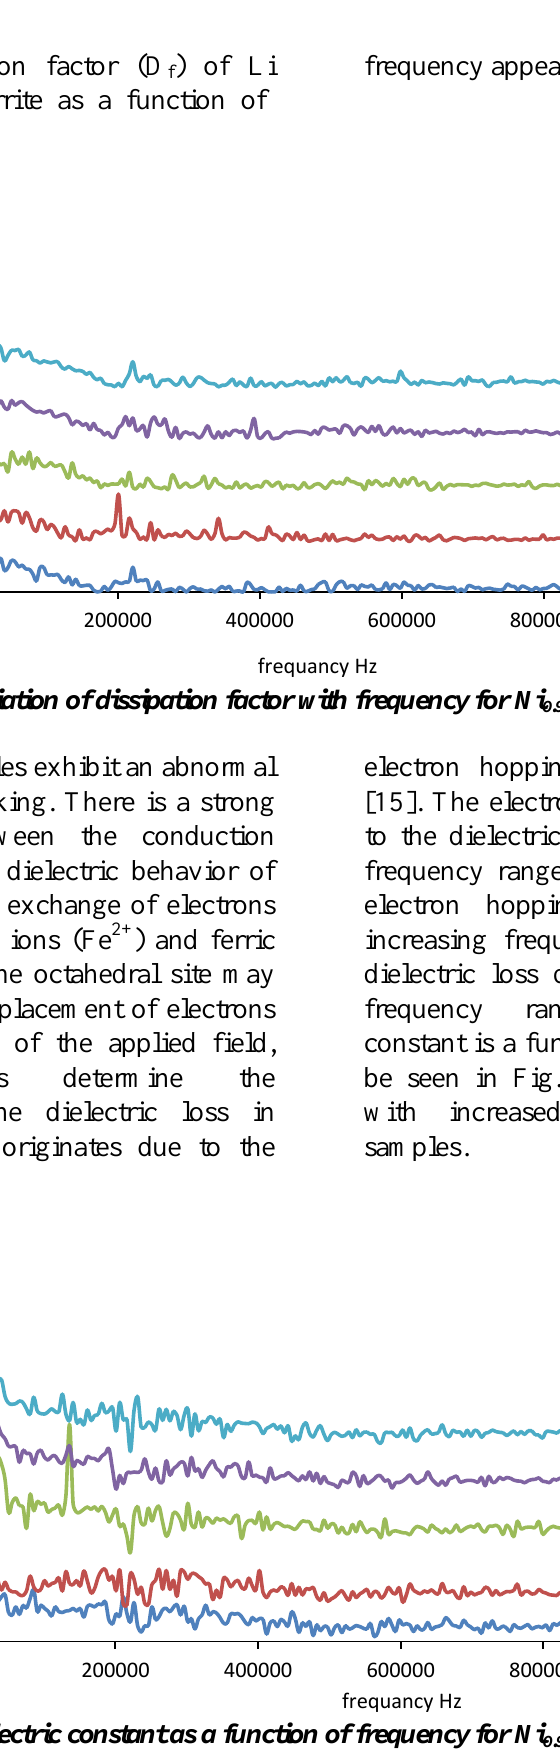
Zn Li Fe O 0.9-2x 0.1 x 2+x 4